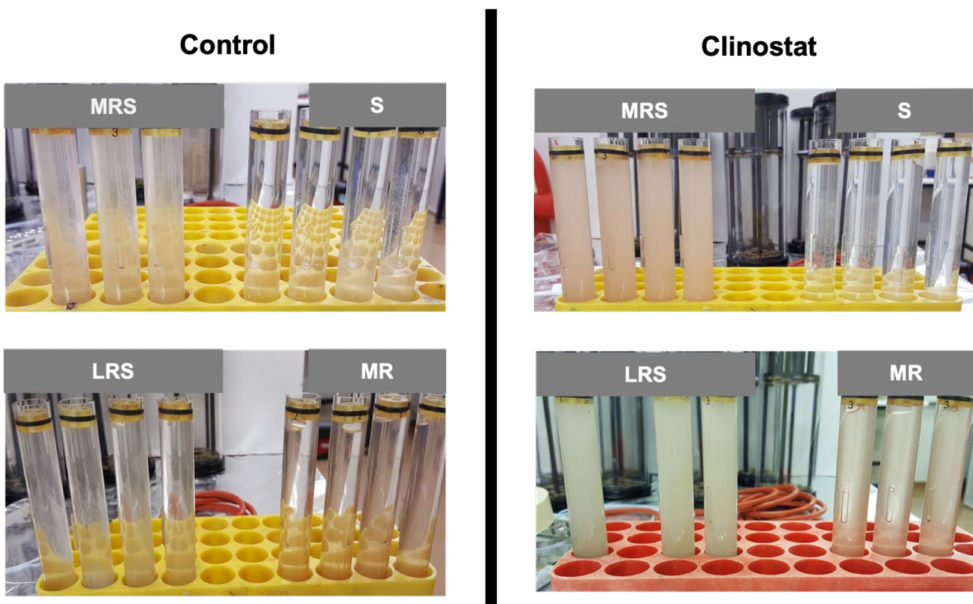
Figure 2. A. ferrooxidans cultured in BioServe’s fluid processing apparatus (FPA) with four substrate alternatives (1% Mars regolith simulant plus 12.5 mM Fe 3+ (MRS); 12.5 mM Fe 3+ (S); 1% lunar regolith simulant plus 12.5 mM Fe 3+ (LRS); 1% Mars regolith simulant (MR) and two gravitational conditions (control and clinostat) at 30 ◦ C for 20 days. H 2 /CO 2 gas mixture was added to all cultures as electron donor and carbon sources,